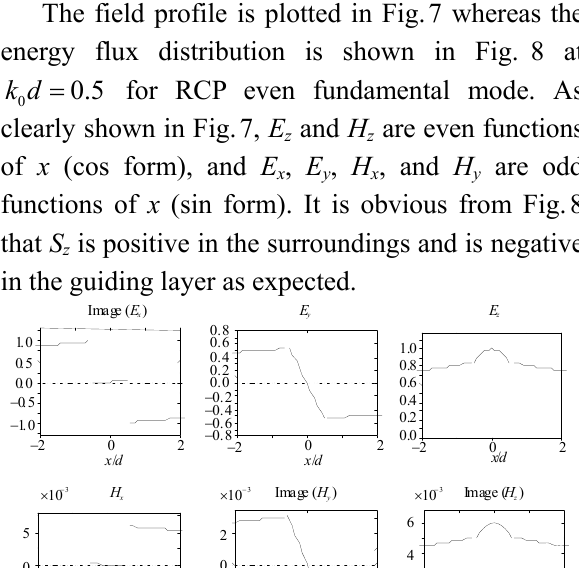
Fig. 6 Energy flux at m = 0.